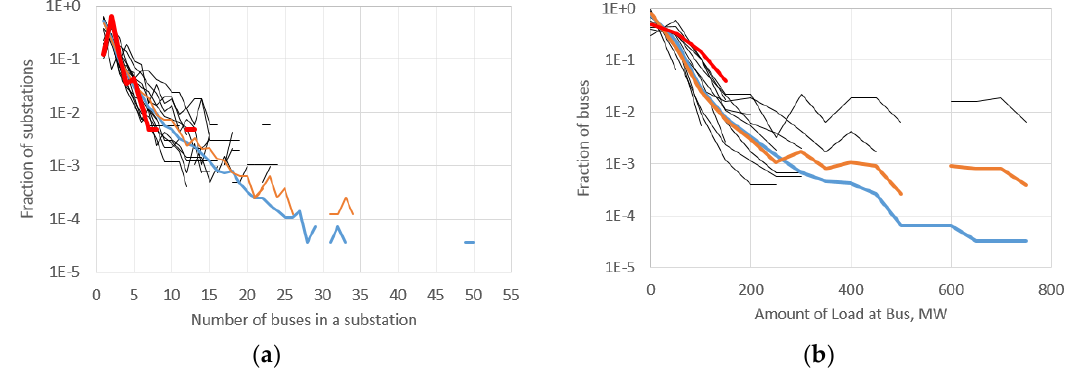
Figure 10. ACTIVSg500 validation plots. ( a ) case distribution of buses per substation (red); ( b ) case Figure 10. distribution of bus loads (red). The other lines are identical to Figures 1 and 2, respectively. Table 6. Validation of ACTIVSg200 and ACTIVSg500 cases. Table 6. Validation of ACTIVSg200 and ACTIVSg500